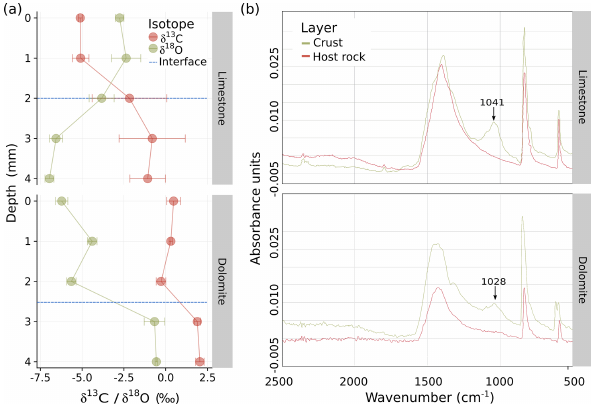
Figure 2. (a) Carbon and oxygen isotope ratio depth profiles of the limestone (top) and dolomite (bottom) BRCs compared with to their host rocks. The blue horizontal line indicates the border between BRC and host rock. (b) Fourier transform infrared (FTIR) analysis of limestone (top) and dolomite (bottom) BRCs indicating the pres- ence of extracellular polymeric substance (EPS) molecules through the distinctive peak ranging between 1020 and 1040cm − 1 , which was absent from the host